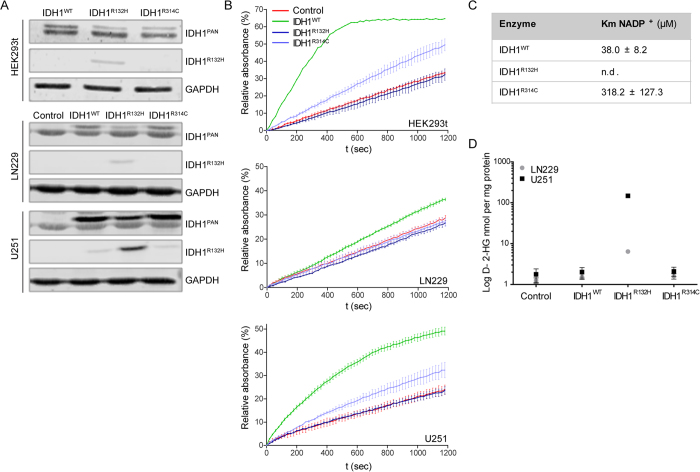
IDH1R314C-BAPHIS expression in glioma cell lines leads to reduced forward activity compared to IDHWT expression.(A) Western blots showing expression of IDH1-BAPHIS in transiently transfected HEK293t and lentivirally transduced LN229 and U251 glioma cells. Blots were stained with anti-IDH1PAN and anti-IDH1R132H as indicated, or with anti-GAPDH as a loading control. Since the recombinant proteins are ~3 kDa larger than endogenous IDH1 they can be distinguished from the endogenous IDH1. Control LN229 and U251 were transduced with empty vector virus (EV). (B) Monitoring of NADPH formation after isocitrate/NADP+ addition to extracts from transfected/transduced cell lines. NADPH formation was monitored by absorbance measurements at 340 nm. Note that IDH1R314C-BAPHIS was far less effective in oxidative carboxylation of isocitrate than IDH1WT-BAPHIS. (C) Km values of IDH1-GST for NADP+. The Km value for NADP+ for IDH1R132H-GST could not be determined. (D) D-2-HG production by IDH1-BAPHIS expressing cell lines was measured with LC-MS. Only IDH1R132H-BAPHIS expressing cells were capable of D-2-HG production.